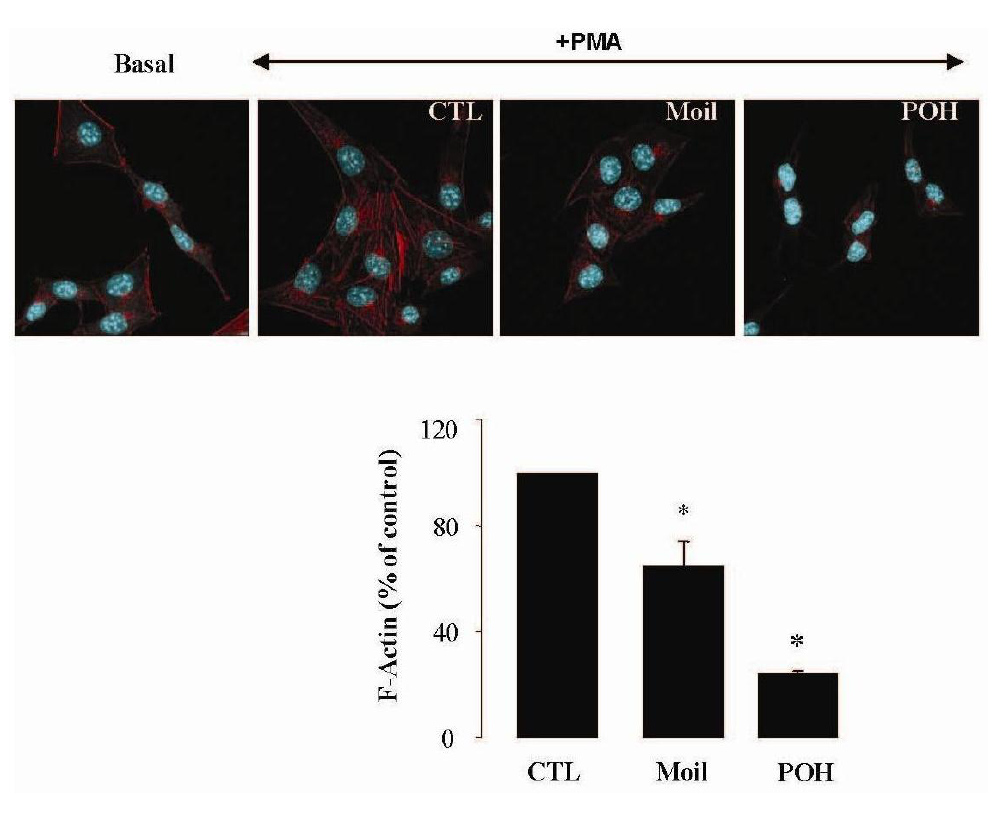
Figure 2. Mastic oil inhibits actin polymerization in PMA-induced LLC cells. Serum-starved LLC cells were treated with Moil (0.04% v/v), POH (1.0 mM) or vehicle (CTL) for 3 h and then induced by 1 μM PMA or vehicle (basal) for 30 min. Cells were fixed and F-actin was visualized by phalloidin staining. Top panel: representative micro-photographs (630 X magnification); bottom panel: graphs from image analysis of F-actin staining normalized to cell numbers and expressed as mean (% of control) ± SEM; n = 96–160, *P <